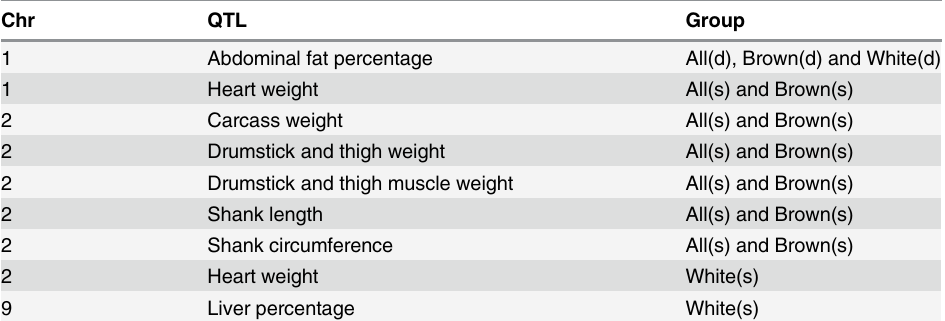
Table 4. QTL associated with productive traits in hapFLK analysis in all three studies. ‘ All ’ , ‘ White ’ , and ‘ Brown ’ , stand for inclusion of all the commercial breeds, analysis within white layers and analy- sis within brown layers, respectively. ‘ s ’ stands for similarity and ‘ d ’ for